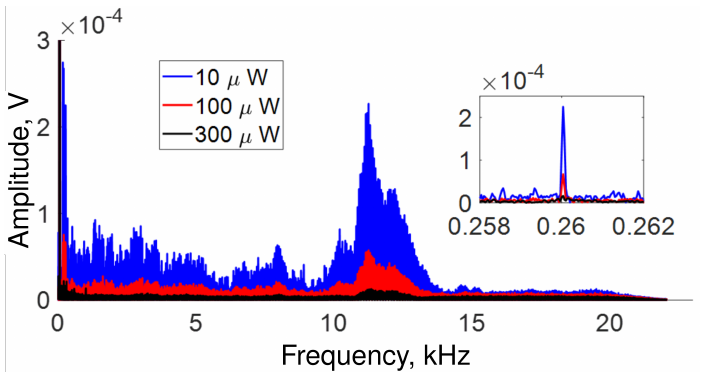
Figure 8. Response of OFSI for a sweep of frequencies from 0 kHz to 23 kHz over 30 s for several average power values adjusted by the angle α of the QWR (see Figure 1).